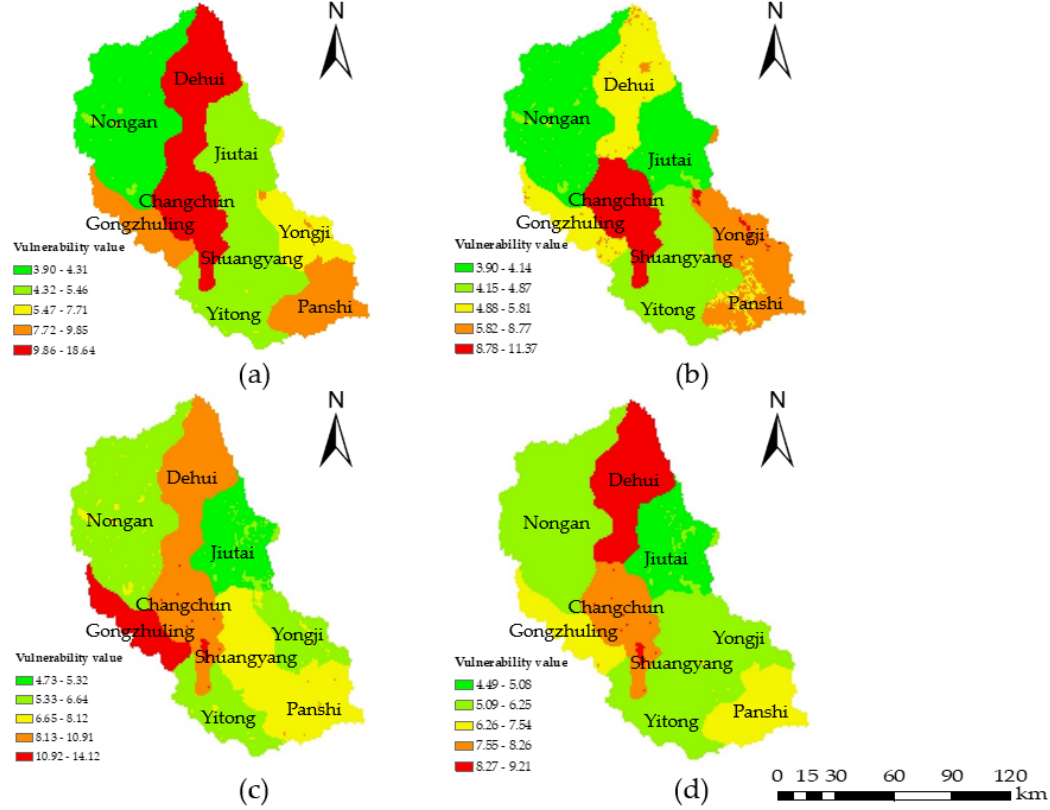
Figure 5. Water environmental vulnerability maps of ( a ) 2000; ( b ) 2005; ( c ) 2010; and ( d ) 2015. The color scale from green to red represents slightly vulnerable, lightly vulnerable, moderately vulnerable, highly vulnerable, and extremely vulnerable, respectively.